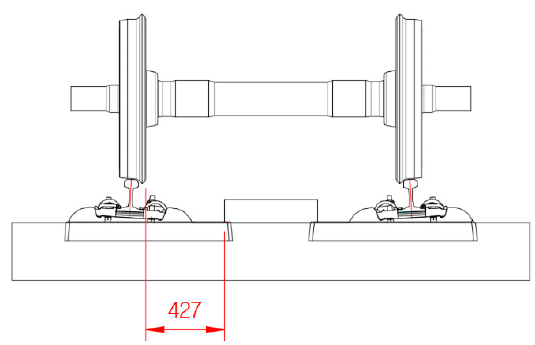
Figure 25. Available displacement between the DCP and the wheel.